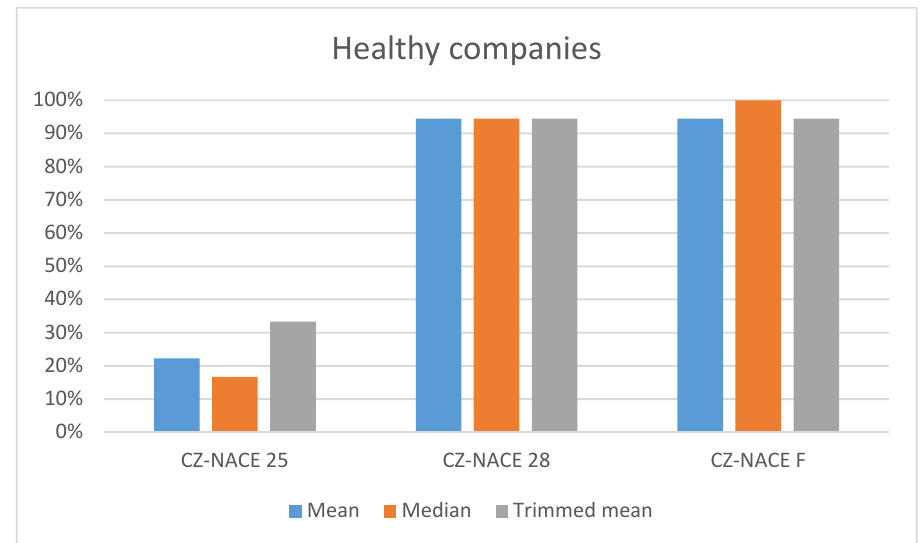
Figure 5. The number of models within each branch confirming better conditions for healthy companies. Source: authors’ own work.